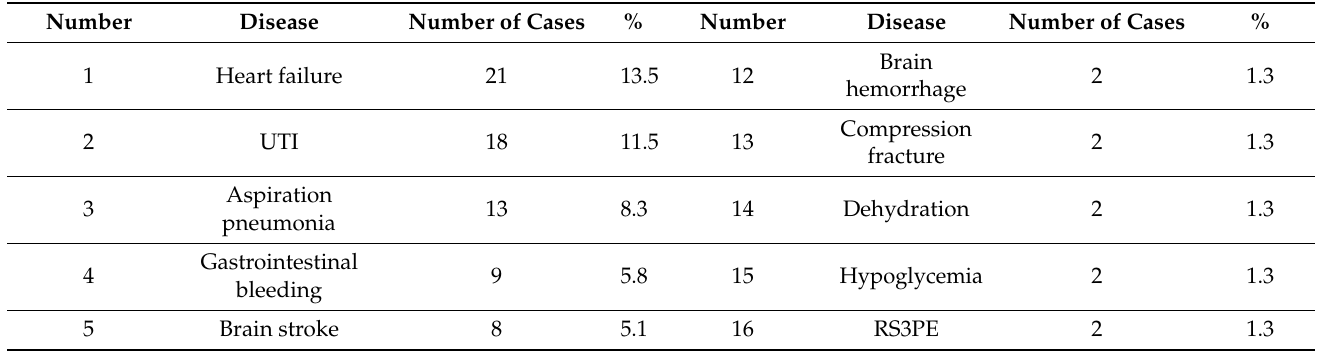
Table 2. Participants’ diagnoses on admission (n =